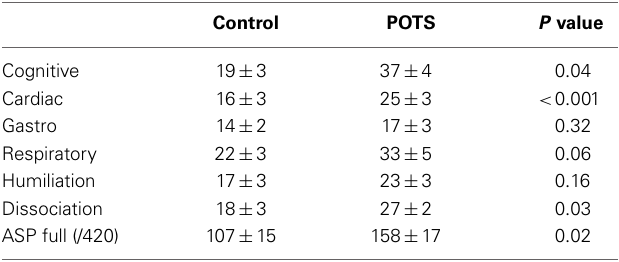
Table 2 | Anxiety sensitivity profile (ASP) scores across multiple domains of symptom anxiety